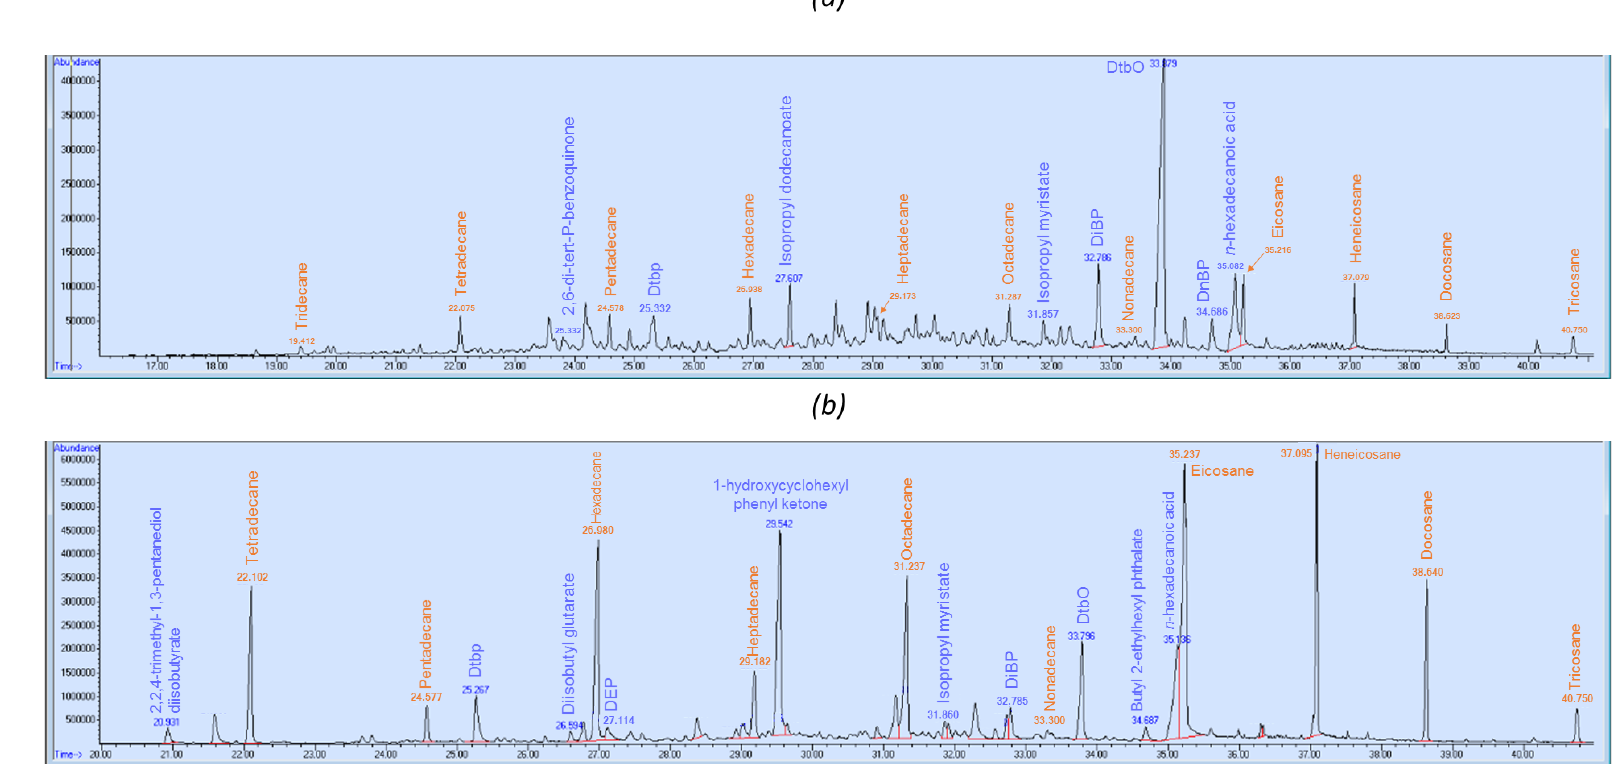
Figure 1. Chromatograms obtained using SPME sampling (PDMS) (T = 110 °C, t adsorption = 30 min) for ( a ) packaging P2 (100% polypropylene (PP)) and ( b ) packaging P6 (coextruded (COEX) 70% linear low density polyethylene (LLDPE)/30% cross-linked low density polyethylene (XLDPE)/ethyl vinyl alcohol (EVOH)).